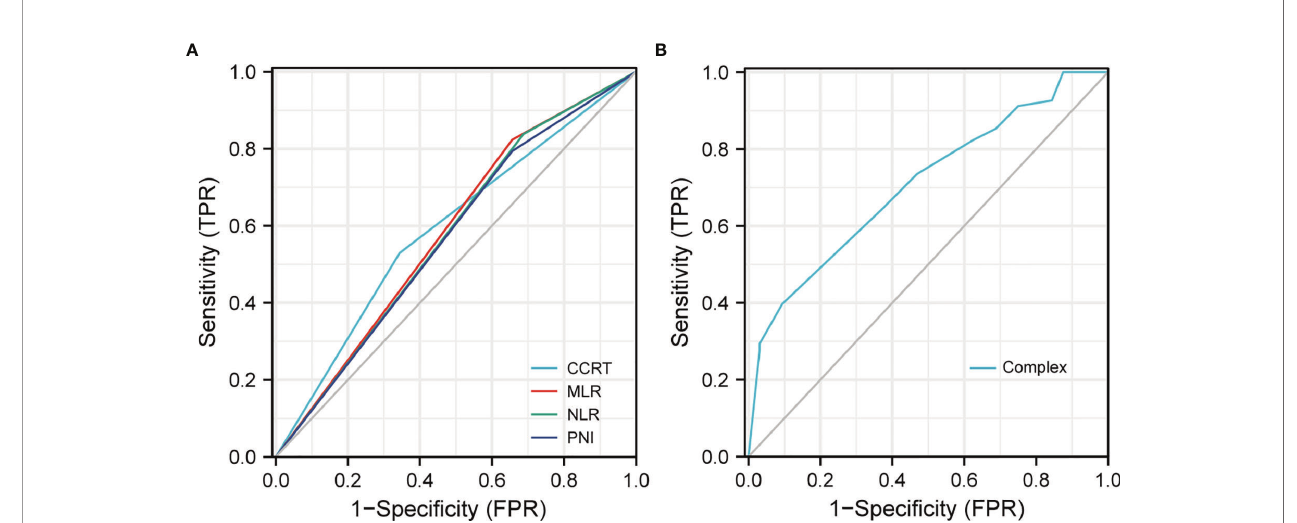
FIGURE 1 | ROC to predict BM. (A) The area under of the curve (AUC) of CCRT, MLR, NLR, and PNI was 0.593, 0.584, 0.575, and 0.569. (B) AUC of the complex (CCRT, MLR, NLR, and PNI) was